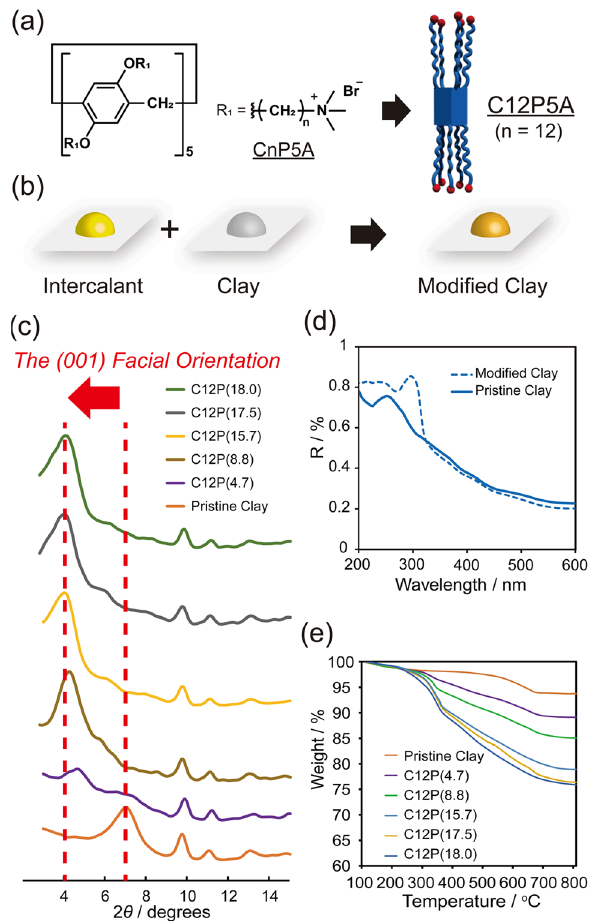
Figure 2. Intercalating C12P5A into bentonite clay. ( a ) Chemical structure of cationic pillar[5]arene. ( b ) Preparation of a modified clay. Differently colored clays were obtained after modification. ( c ) Powder X-ray diffraction (PXRD) patterns of the modified clays (C12P(X), where X denotes the percentage of C12P5A loaded in the clay). The peak associated with the interlayer distance increased with an increase in the amount of C12P5A. ( d ) UV–Vis absorption spectra of the pristine and modified clays. The peak for the benzene ring at 295 nm was only observed for the modified clay. ( e ) Thermogravimetric analysis (TGA) traces for calculating the amount of